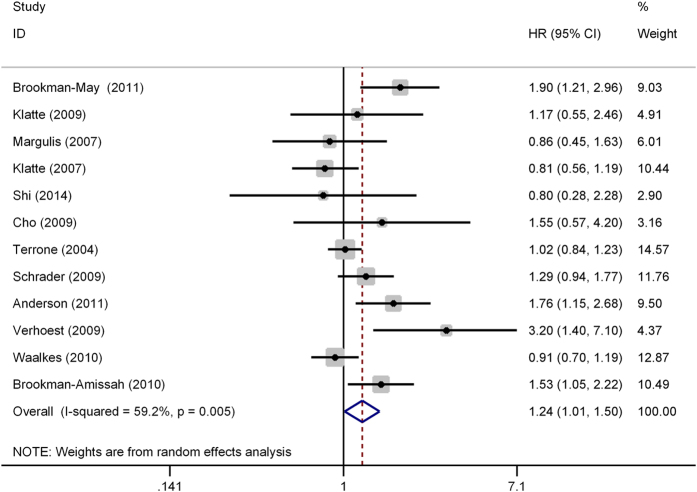
Forest plot of studies evaluating the association between urinary collecting system invasion and cancer-specific survival of renal cell carcinoma.HR = hazard ratio; CI = confidence interval.